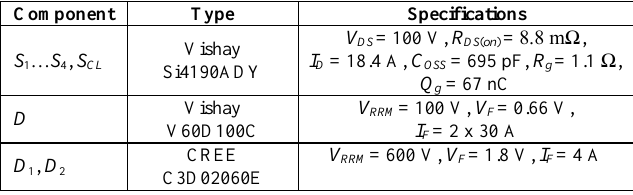
S EMICONDUCTOR C OMPONENTS S ELECTED FOR THE S IMULATION